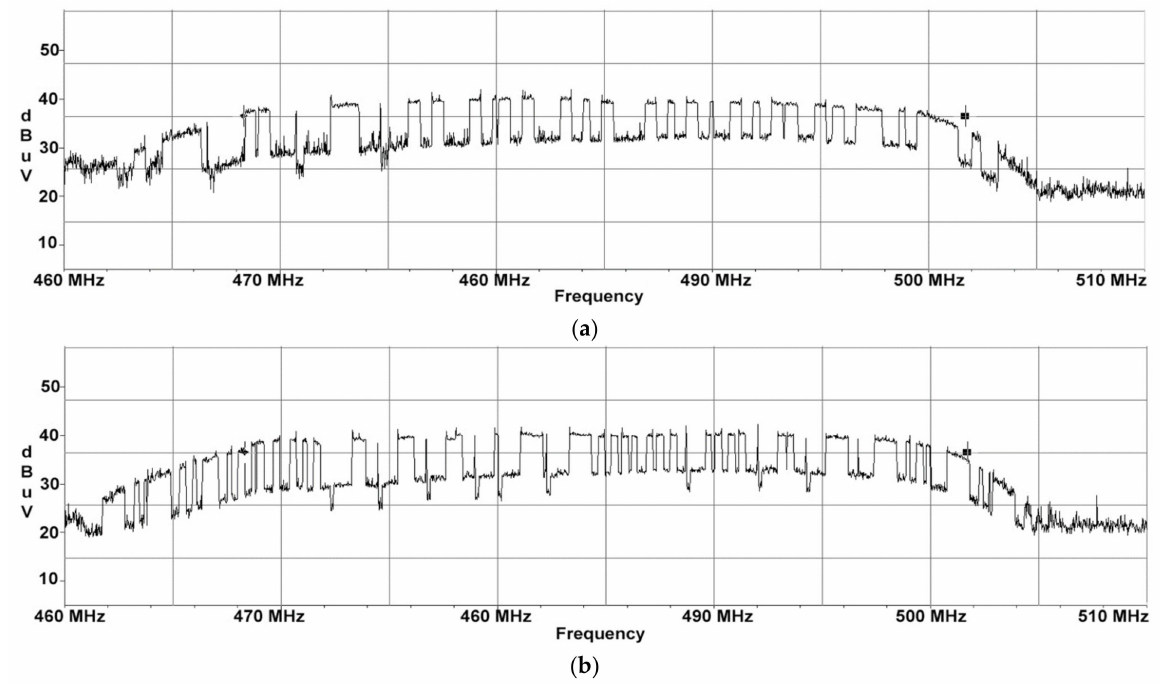
Figure 2. AOC display unit: ( a ) frequency sweeps performed for test signal consisting of 3 horizontal bars equal in width; ( b ) frequency sweeps performed for test signal consisting of 1 thick horizontal line and 3 thin horizontal lines equal in